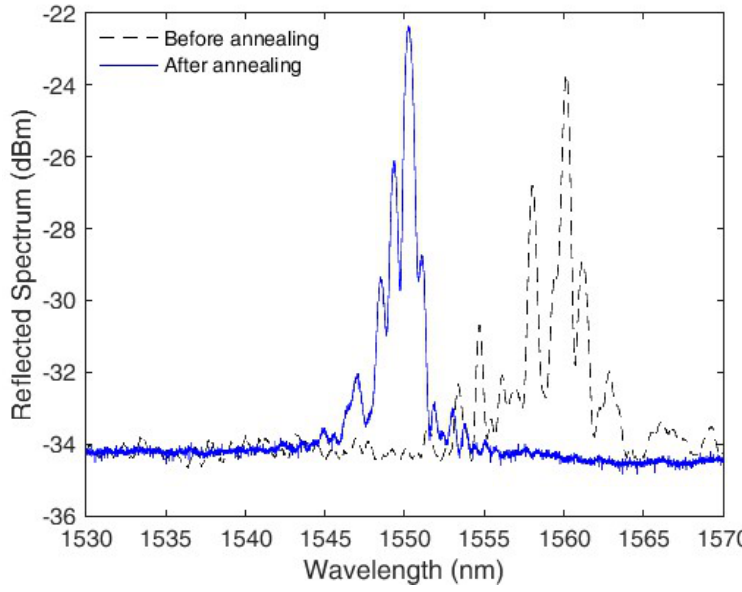
Figure 4. Polymer optical fiber Bragg gratings (POFBG) spectrum before and after the annealing.